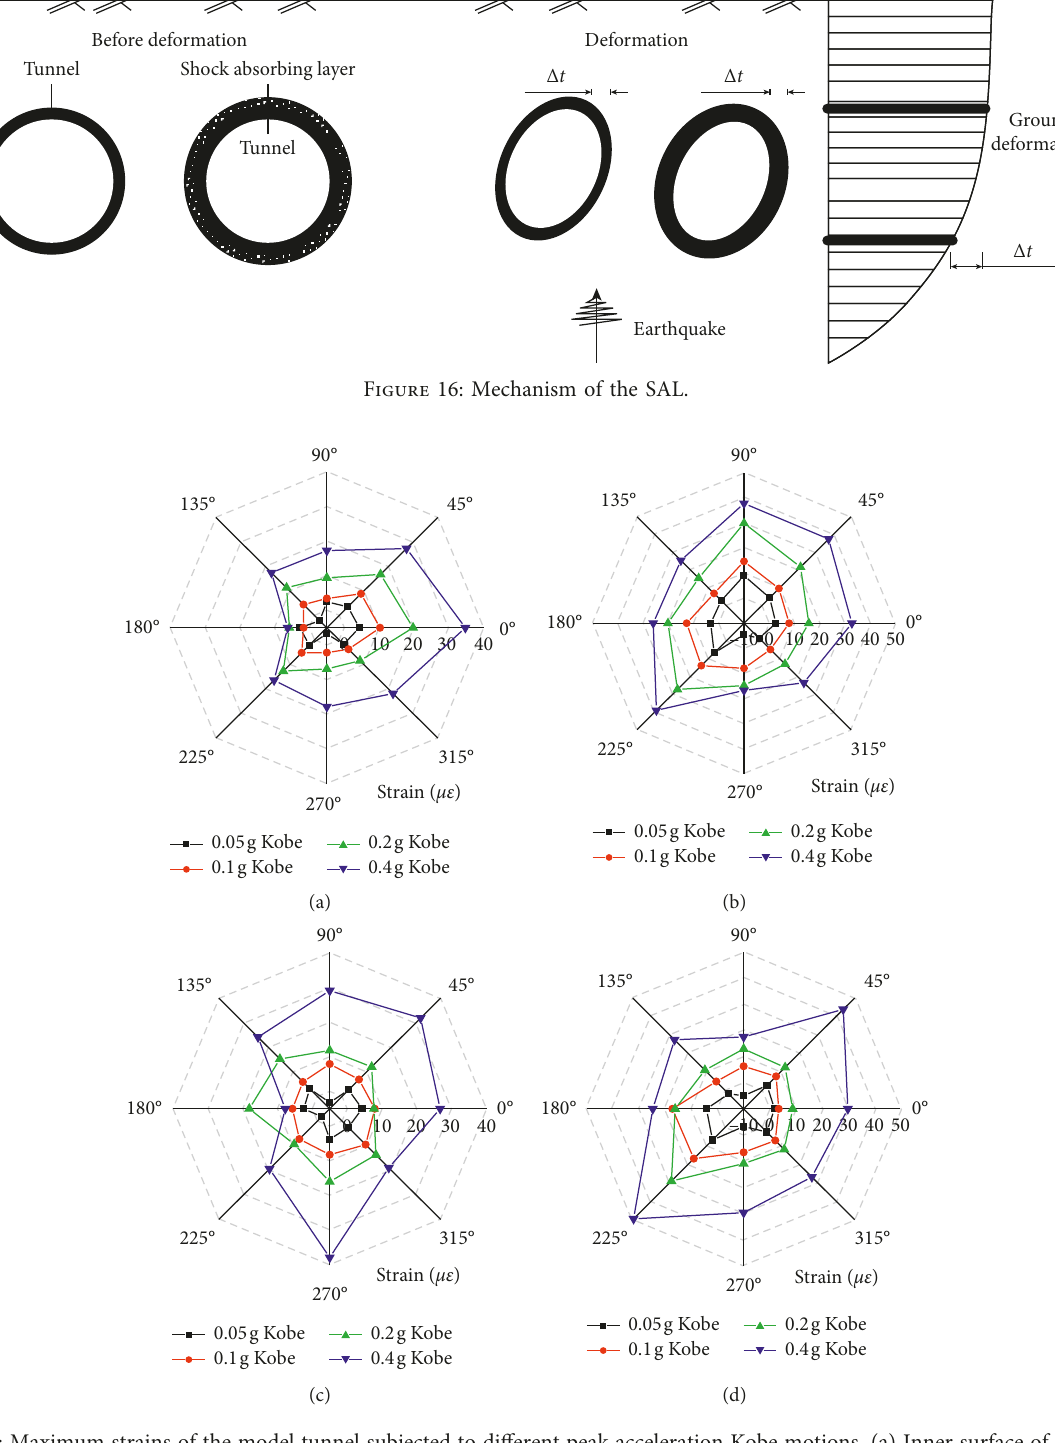
Figure 17: Maximum strains of the model tunnel subjected to different peak acceleration Kobe motions. (a) Inner surface of the tunnel longitudinal. (b) Inner surface of the tunnel hoop. (c) Outer surface of the tunnel longitudinal. (d) Outer surface of the tunnel